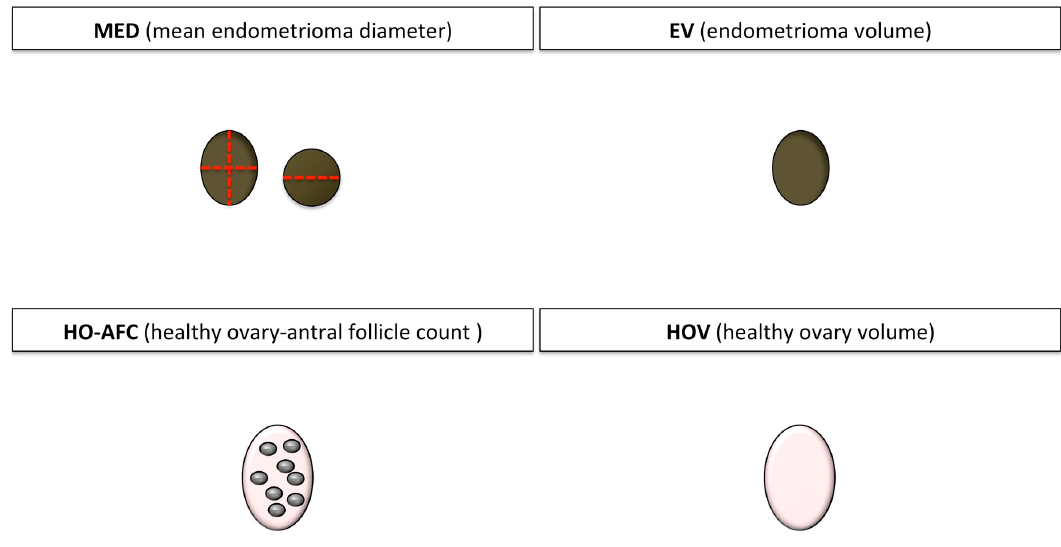
Figure 1. Schematic diagram of the four absolute sonographic indicators. Brown circle: Endometrioma; dotted red line: Measure line; grey circle: Antral follicle; pink oval: Contralateral healthy ovary.